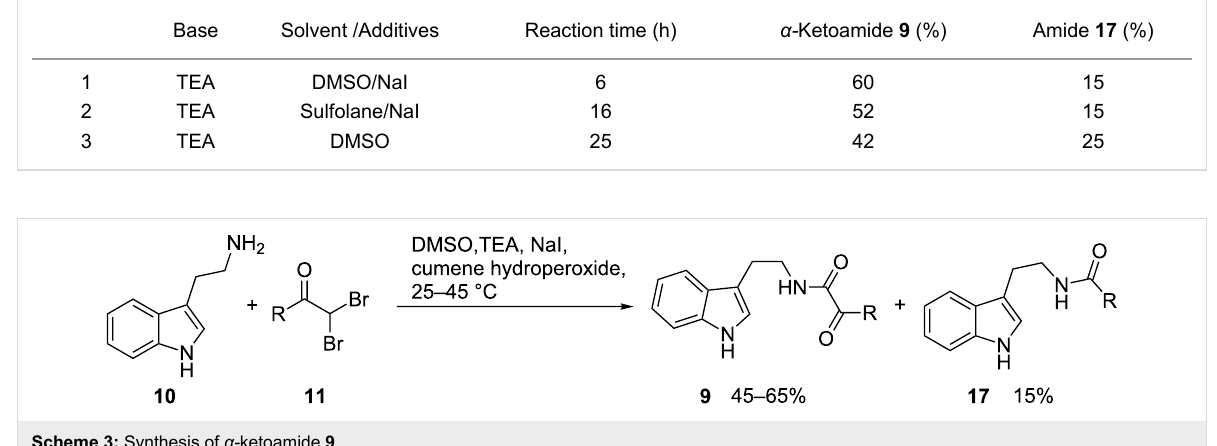
Table 1: Effect of solvent and additive on the ratio of 9 and 17